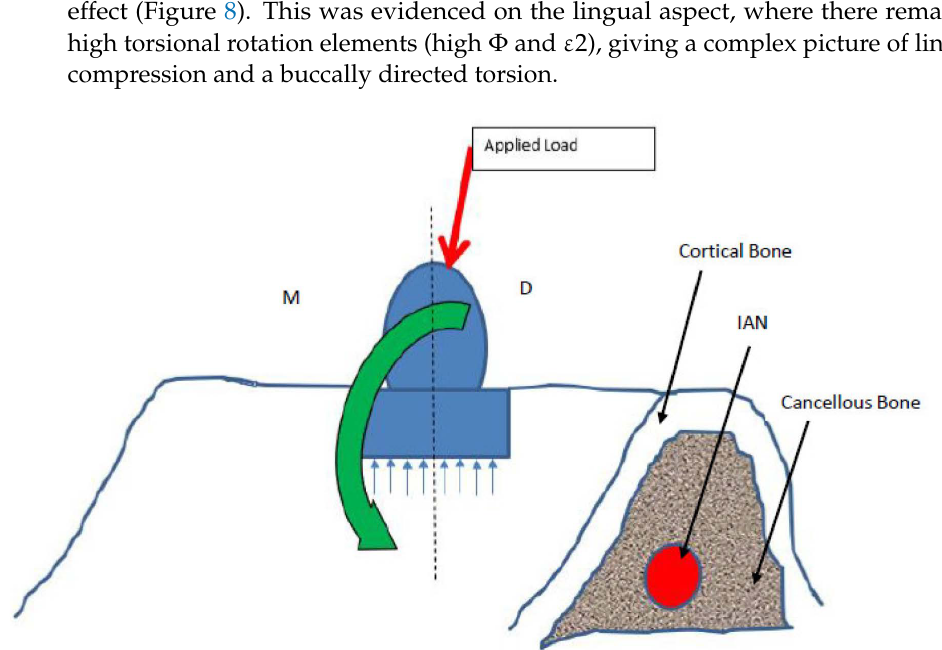
Figure 8. Vertical bucco-lingual torsional effect: buccal view. The red arrow depicts the applied force, while the vertical green arrow depicts the bucco-lingual “vertical” resultant moment generating the cortical torsional strains in this orientation. It should be noted that there would also be a “vertical” apical equal and opposite reactive force evenly distributed along the flat face of the block (blue arrows). The measurement of this element was beyond the scope of this experiment. (IAN: inferior alveolar